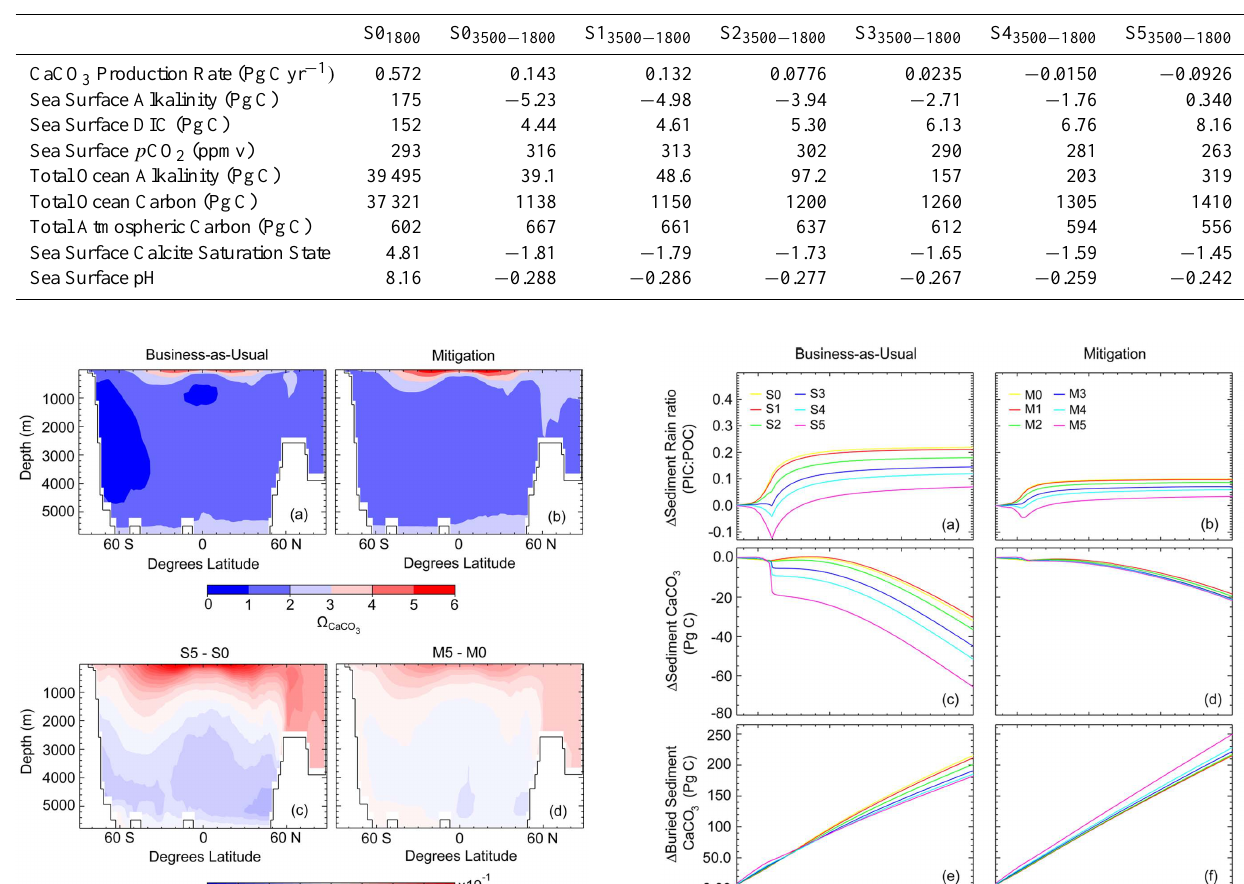
Table 2. Summary of the change in atmospheric and ocean output for years 1800–3500 for Suite S simulations. Values in column S0 1800 represent absolute output in the base model in year 1800. Subsequent columns show differences from 1800 to 3500 for each calcification sensitivity (S0 to S5).